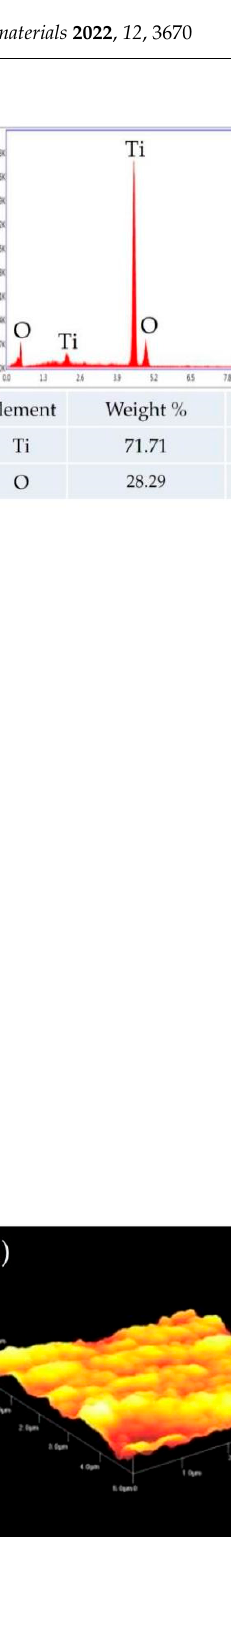
Figure 13. Characteristic features of TiO 2 NPs dependent on characterization, showing the surface functionality, size distribution, particle shape, porosity, surface area, particle size, composition, sur- face, crystallinity, and agglomeration state [119]. Role of Size and Shape of TiO 2 NPs on Their Medical and Dental Applications The nanometer size of TiO 2 NPs provides them with a high surface energy, a large fraction of surface atoms, reduced imperfections, spatial confinement, and reduced im- perfections in comparison to the corresponding bulk material. At the nanometer scale, the properties of NPs become size- and shape-dependent, which involves chemical properties (reactivity), catalysis, thermal properties (melting temperature), mechanical properties (adhesion and capillary forces), optical properties (absorption and scattering of light),